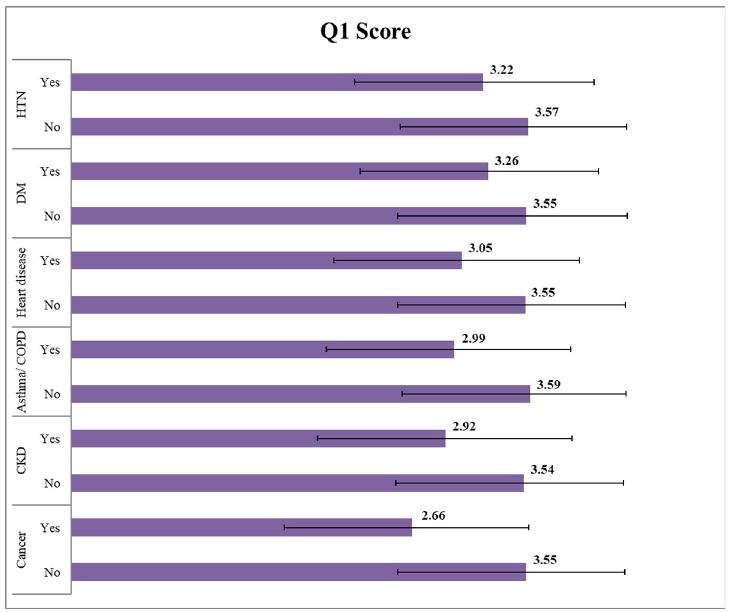
Fig 1. Overall quality of life (Q1 of WHOQOL-BREF) and chronic disease. https://doi.org/10.1371/journal.pone.0257421.g001 Table 5. Comparison of individual domain score by chronic disease status. Physical Psychological Social